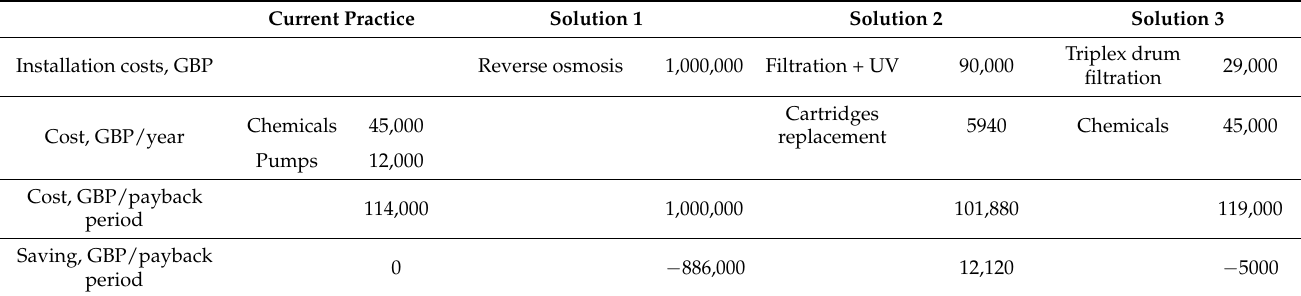
Table 2. Costs associated with the current practice and the solutions offered by each